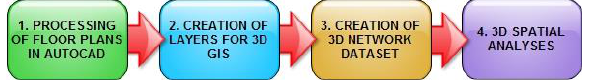
Figure 2. Work flow for the Development of the 3D GIS Dataset